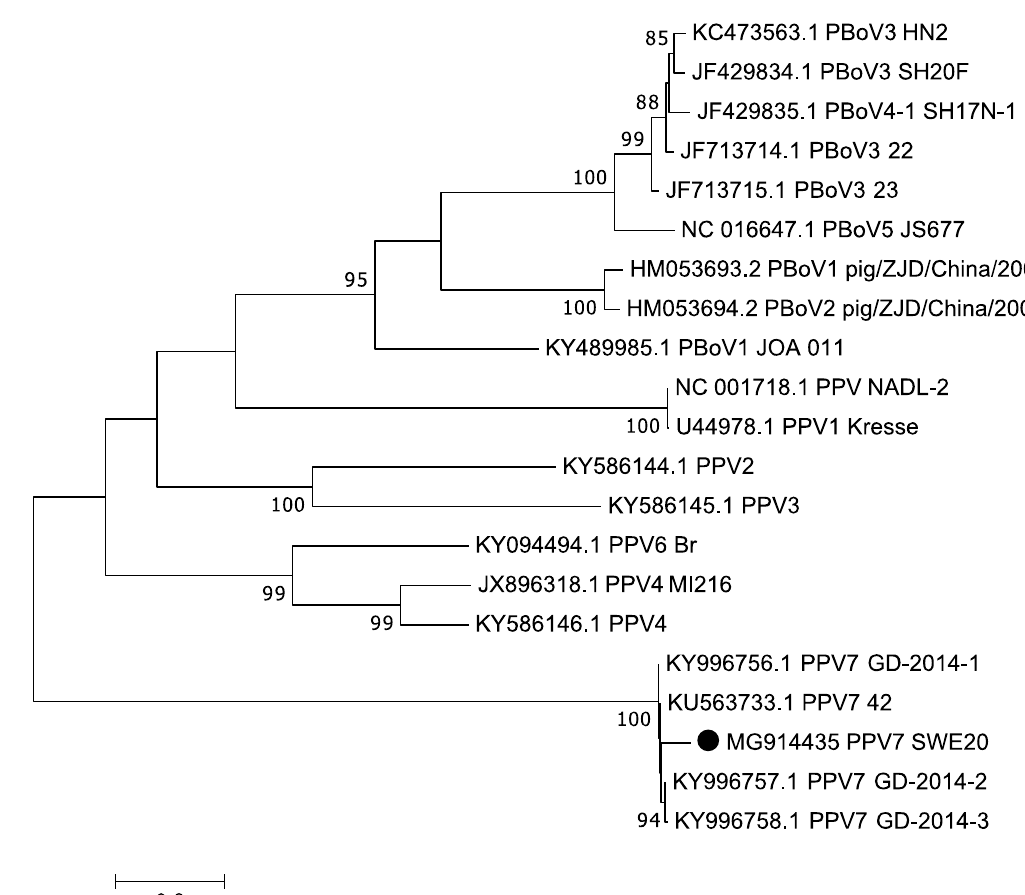
Figure 1. Phylogenetic analysis of porcine parvovirus 7. The evolutionary history was inferred by using the Maximum Likelihood method based on the Tamura Nei model with a bootstrap value of 1000. The analysis is based on the complete nucleotide sequence NS1 gene, and, in total, there were 1483 nt positions in the final dataset. The PPV7 obtained from this study is marked with a black circle, and only bootstrap values greater than 70% are shown.